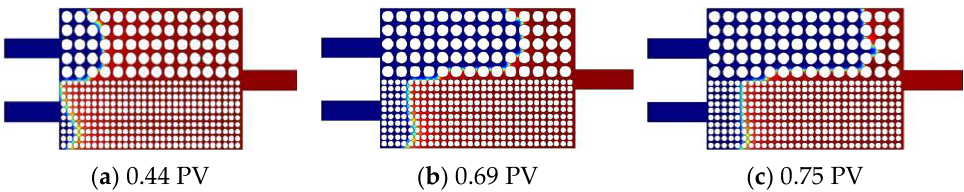
Figure 5. Oil saturation distribution of separated layer injection and commingling production. (The polymer solution is represented in blue and the oil in red)